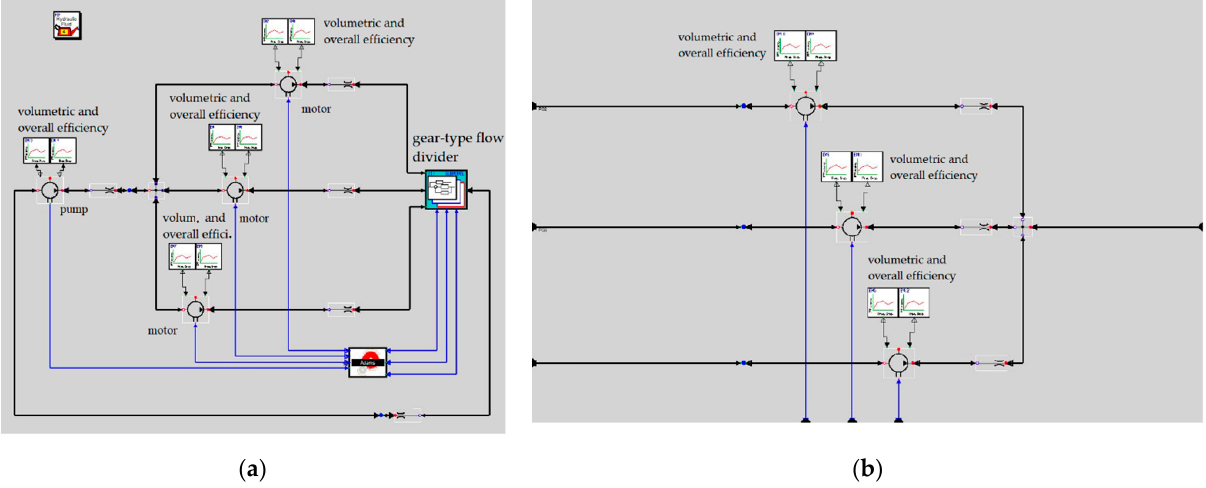
Figure 9. Model of the hydrostatic drivetrain with a gear-type flow divider ( a ) and the model of gear divider ( b ).